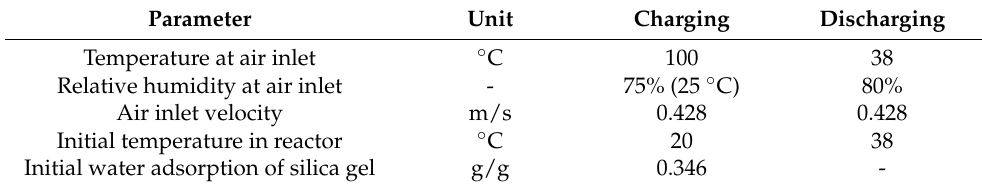
Figure 3. ( a ) 3D stereogram and ( b ) dimensional diagram of the fixed-bed reactor (Unit: mm).